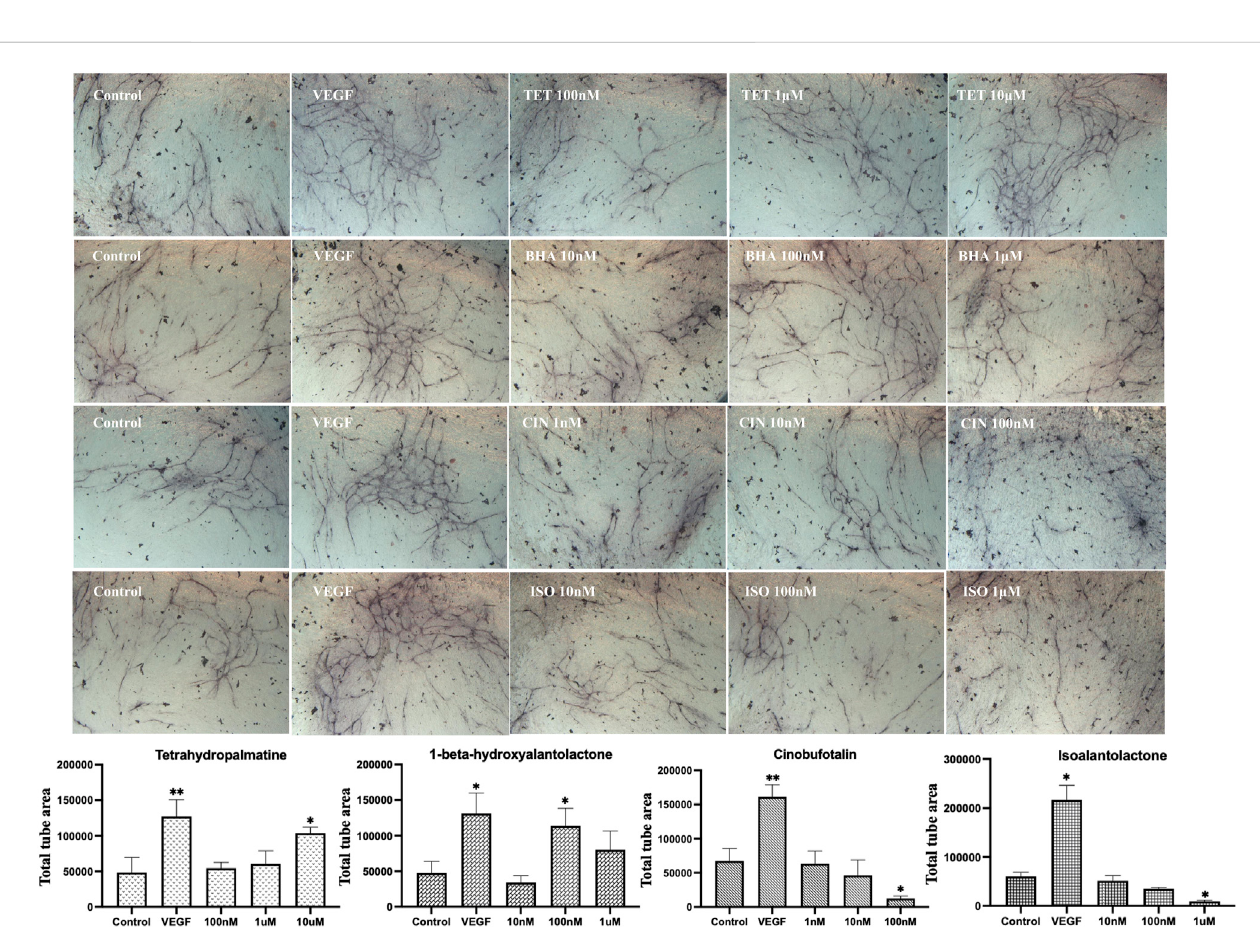
FIGURE 8 Modulation of endothelial tube formation in vitro by tetrahydropalmatine (TET), 1 beta-hydroxyalantolactone (BHA), cinobufotalin (CIN) and isoalantolactone(ISO)selectedbytheMachineLearningmodel.Totaltubeareawasshown.Statisticalanalyseswereperformedbyone-wayANOVAfollowed by Dunnett ’ s post hoc test. Data represents mean ± SEM ( n = 4 – 6). Compared with the control group, * p < 0.05, ** p < 0.01, *** p <